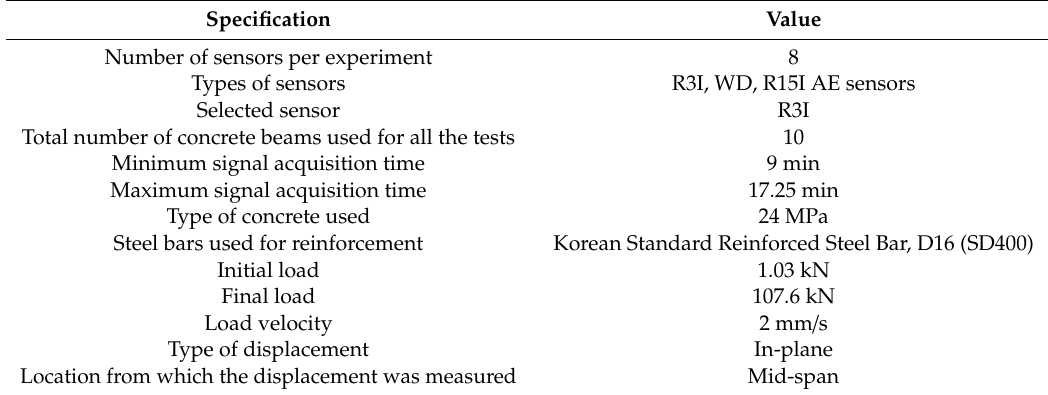
Table 2. Specifications of the